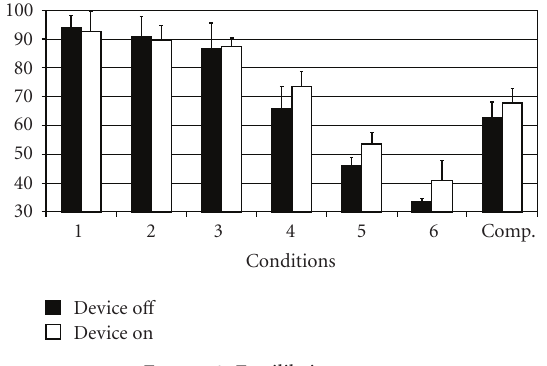
Figure 2: Equilibrium